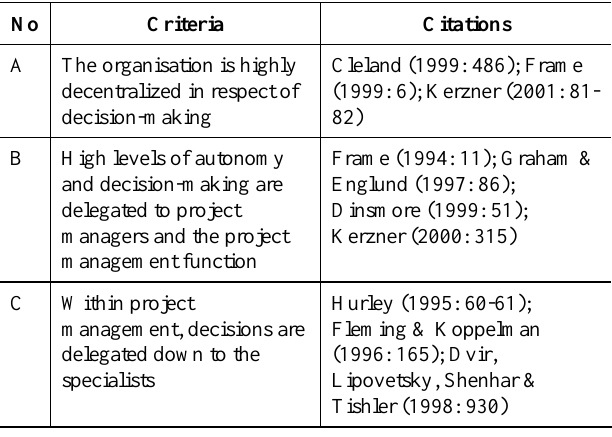
Table 9: The need for a clear direction and vision for the organization